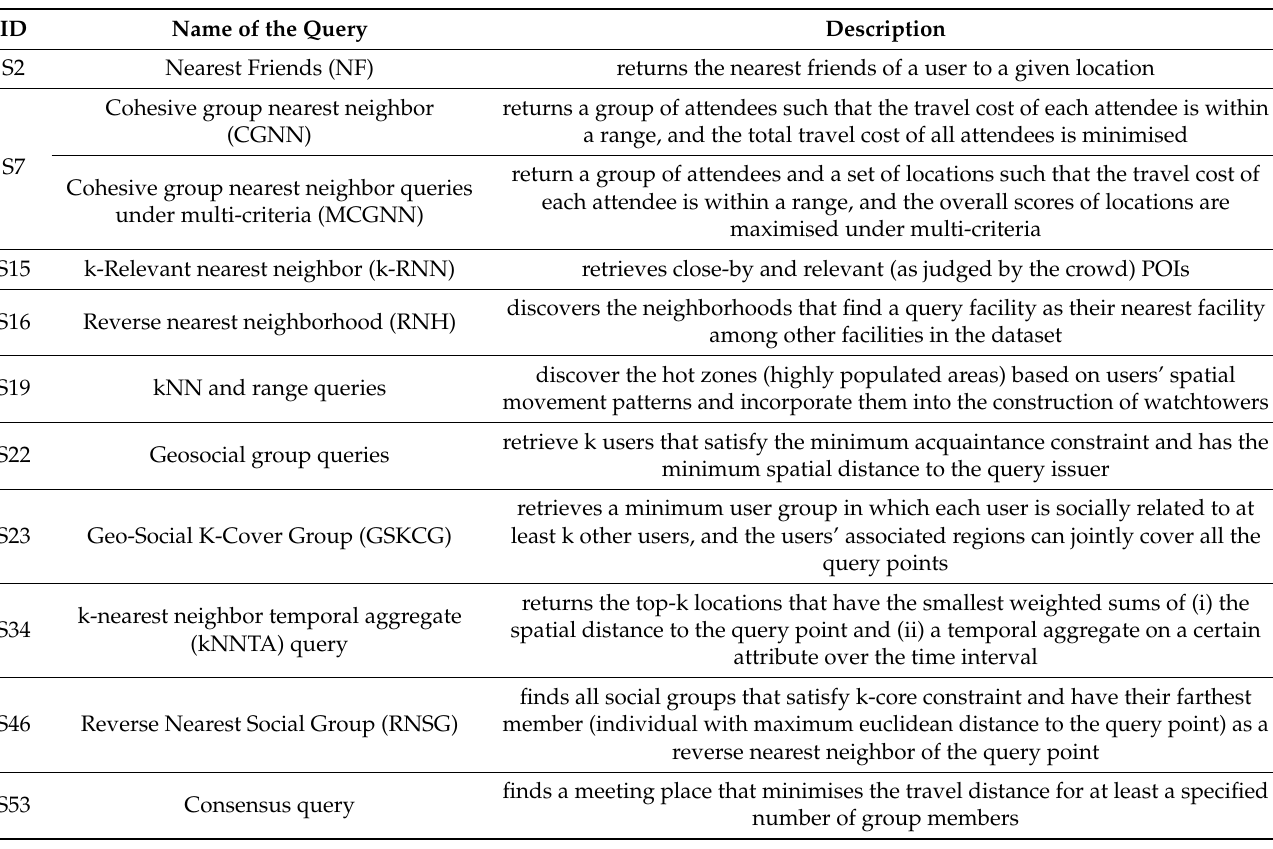
Table 14. Geosocial nearest neighbor queries.